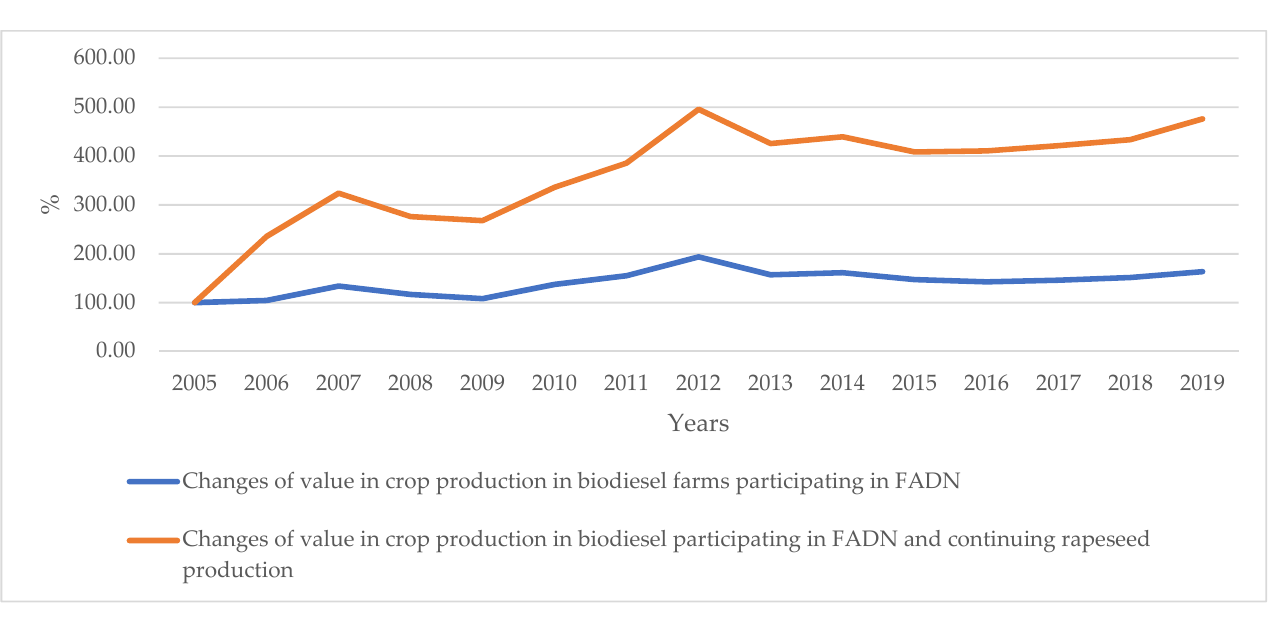
Figure 4. Changes in the value of crop production in Polish biodiesel farms in 2005–2019 [%]. Source: own elaboration based on FADN data [52].